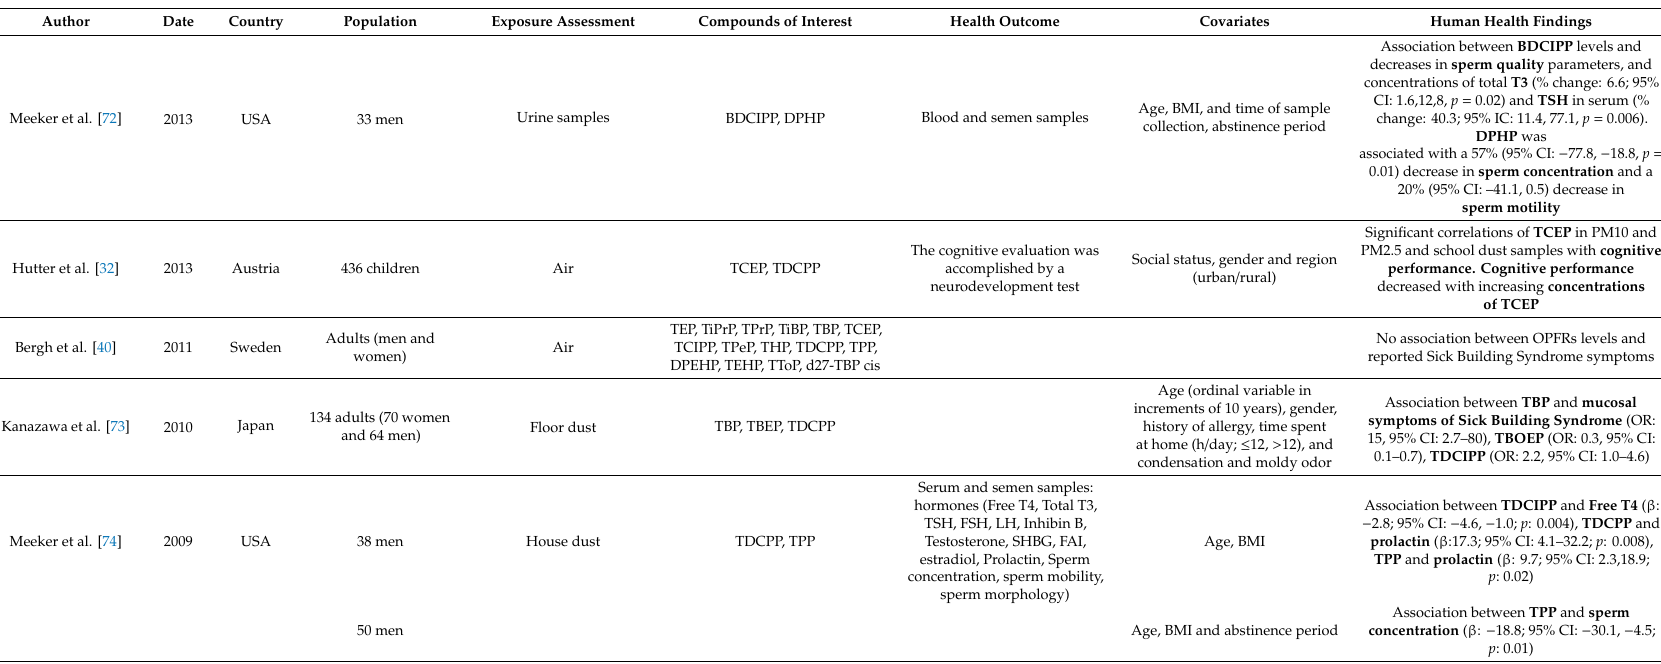
Bold: Key elements of the